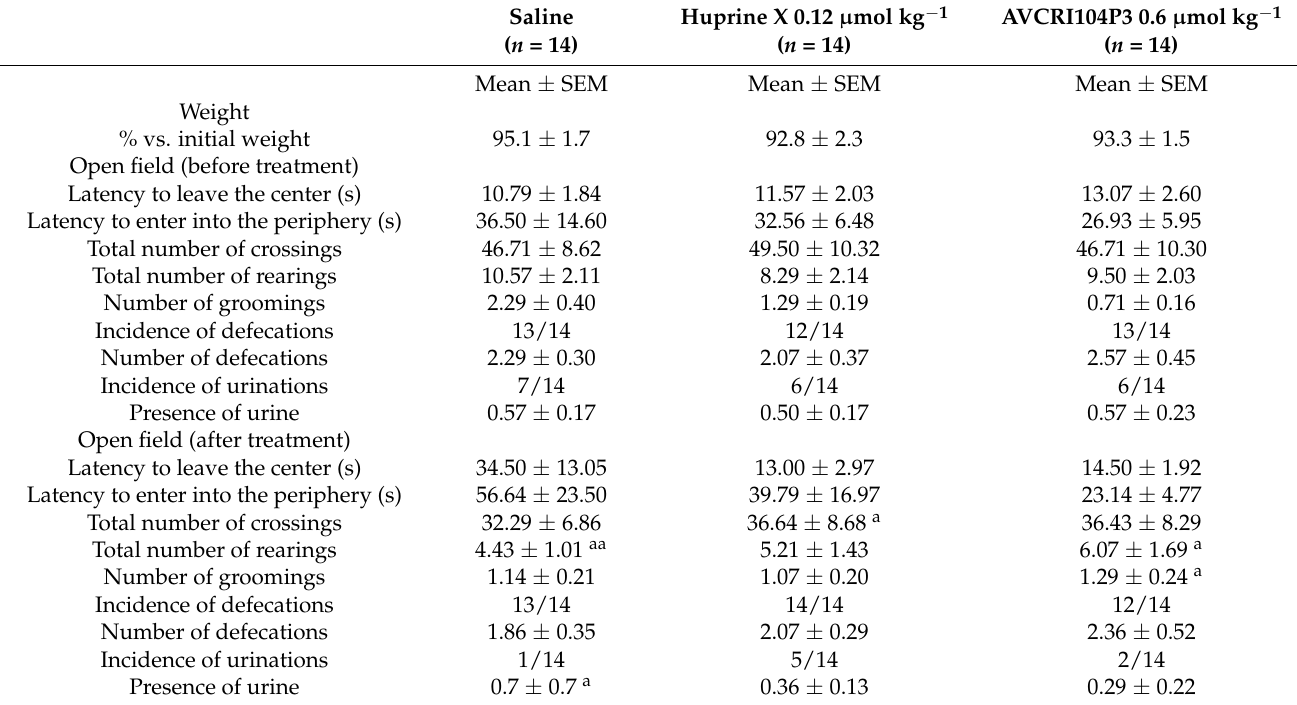
Table 1. Effects of HX and AVCRIP104P3 on BPSD-like behaviors in 3xTg-AD mice at advanced disease stages in each group). Statistics: Student t -test, all n.s. p > 0.05 vs. the saline group; Paired t -test, a p < 0.05, aa p < 0.01vs. before